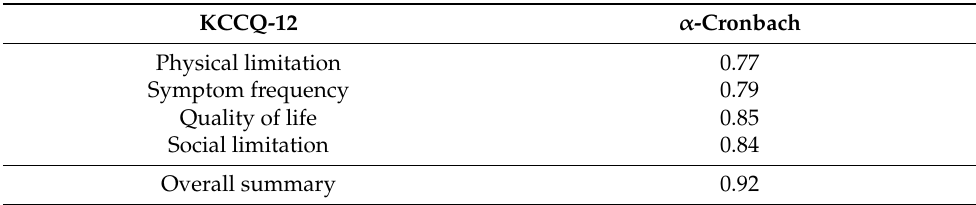
Table 2. Internal consistency of the KCCQ-12.